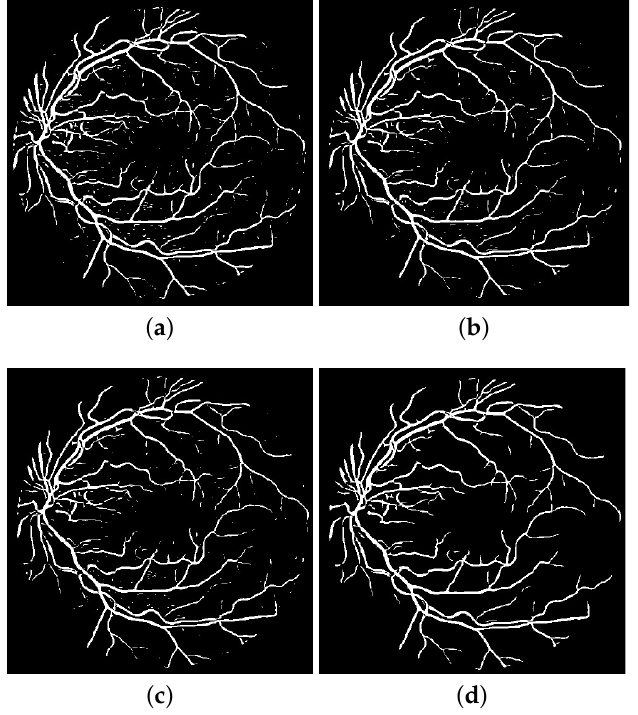
Figure 13. The output of the post-processing module. The mask image is shown in ( a ), the marker image is shown in ( b ), the morphologically reconstructed image is shown in ( c ), and the final binary image or segmented image of retinal blood vessels is shown in ( d